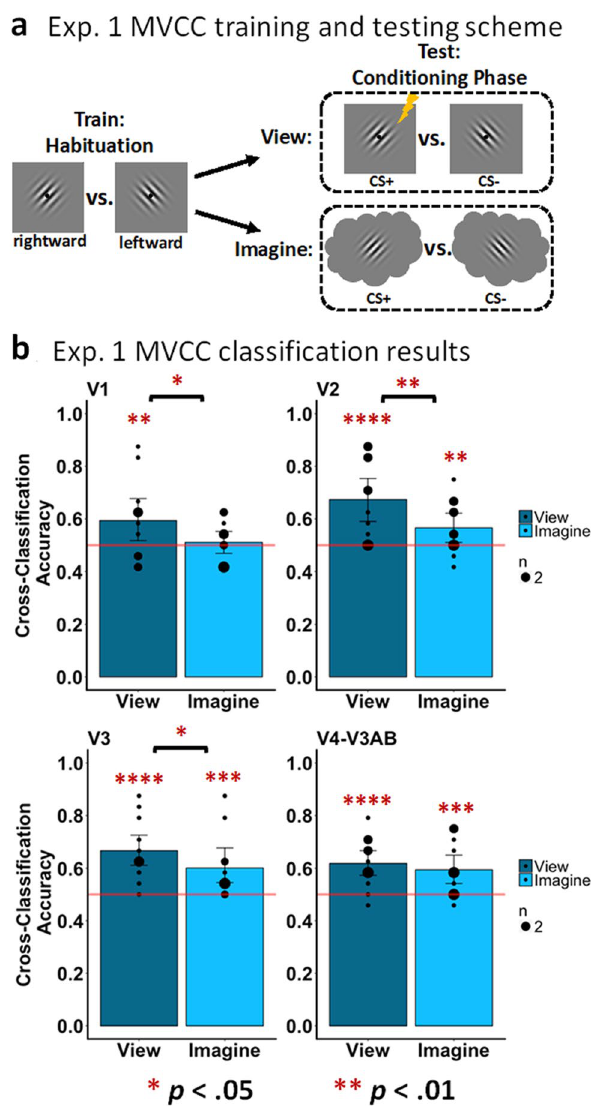
Figure 2. MVCC in early visual cortex during the conditioning phase (experiment 1). ( a ) A graphical representation of the MVCC training and testing scheme. The lightning bolt denotes the CS+ but the MVCC analysis excluded trials in which shock was delivered. ( b ) results of the MVCC classification of view trials (vCS+ vs. vCS−; dark-gray bars) and imagine trials (light-gray bars) in V1 (top-left), V2 (top-right), V3 (bottom- left), and V4-V3AB (bottom-right). The horizontal line represents chance (50%), and the black dots represent how many participants had a given classifier